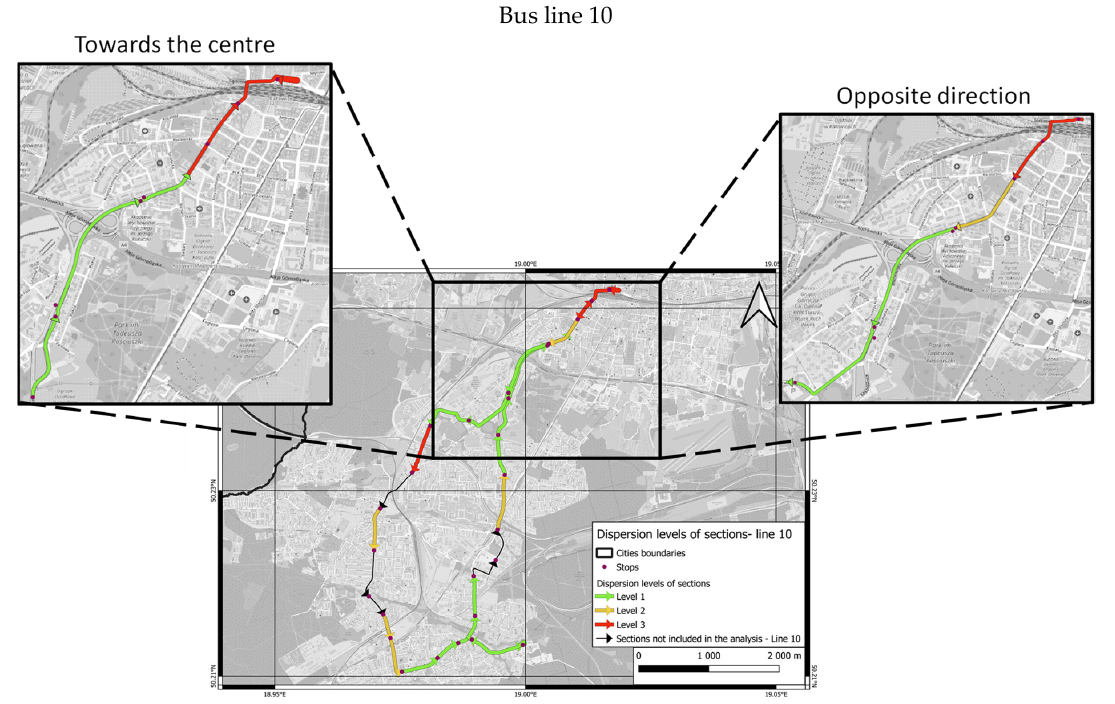
Figure 4. Graphical presentation of interstop sections corresponding to specific levels of disturbance.